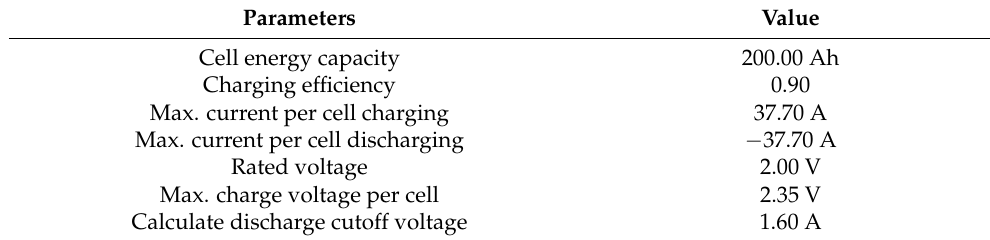
Table 3. Technical data of storage